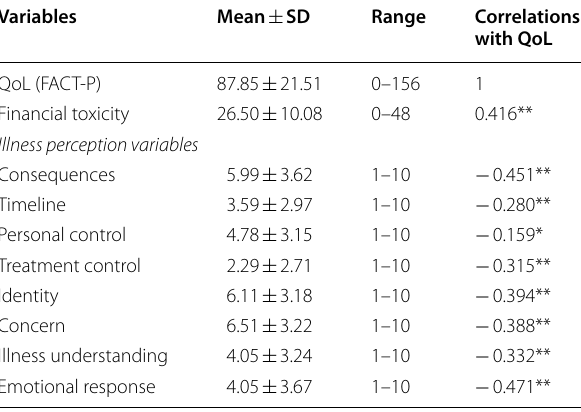
Table 2 Correlation between financial toxicity and subscales of illness perception with overall quality of life